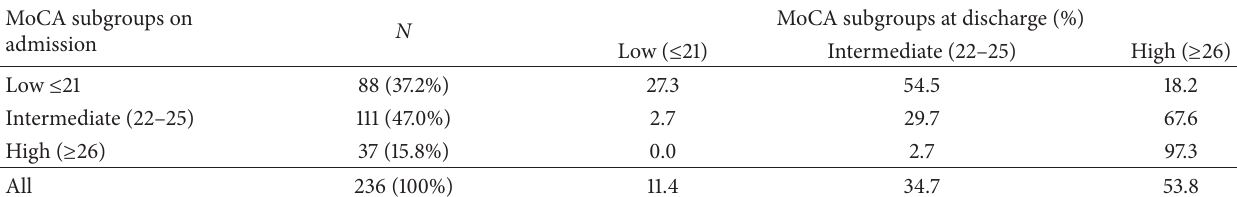
Table 4: Changes in MoCA subgroup distribution from admission to